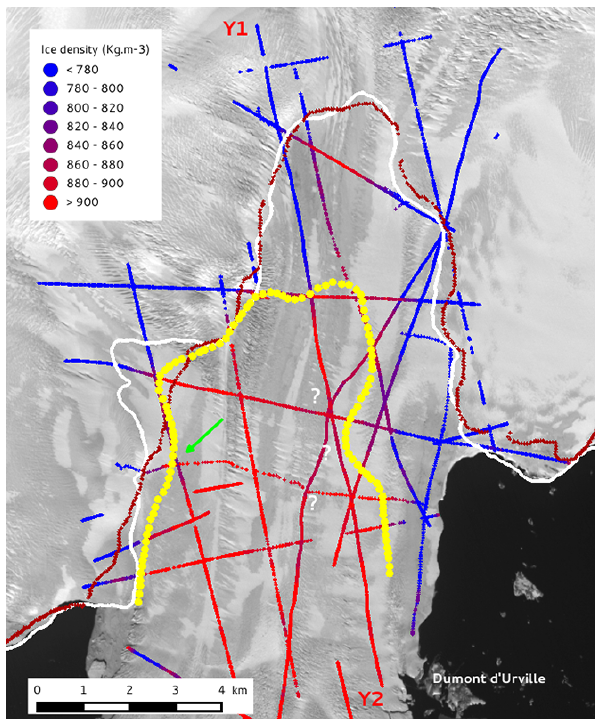
Figure 8. Hydrostatically determined transitions between grounded (blue) and floating (red) ice along all radar profiles performed over the coastal part of the Astrolabe Glacier as a function of the cho- sen value for ice density. Assuming the central value of 880kgm − 3 for the ice density the resulting grounding line is indicated by the yellow line. The green arrow points towards the radar profile inter- section where a large discrepancy in ice thickness is observed. Y1 and Y2 denote both ends of the radar profile of Fig. 7. Question marks indicate places of possible partial grounding (pinning points) whereas a significant increase in density some 2km inland of the proposed GL denotes the possible presence of an isolated trough. Lastly, the white and brown lines are the grounding lines proposed by Bindschadler et al. (2011) and that of the 2009 updated data set of Scambos et al. (2007)